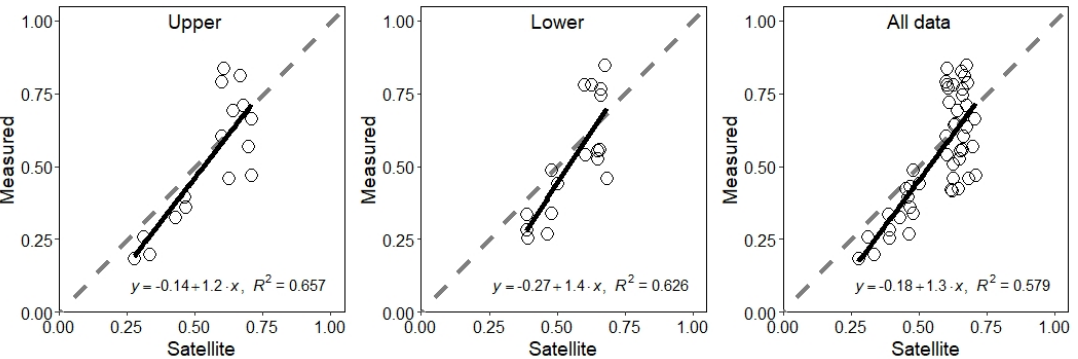
Figure 8. Relationships between the measured and satellite-retrieved NDVI values for the upper, lower, and all measurement points. n = 16, 17, and 47, respectively.